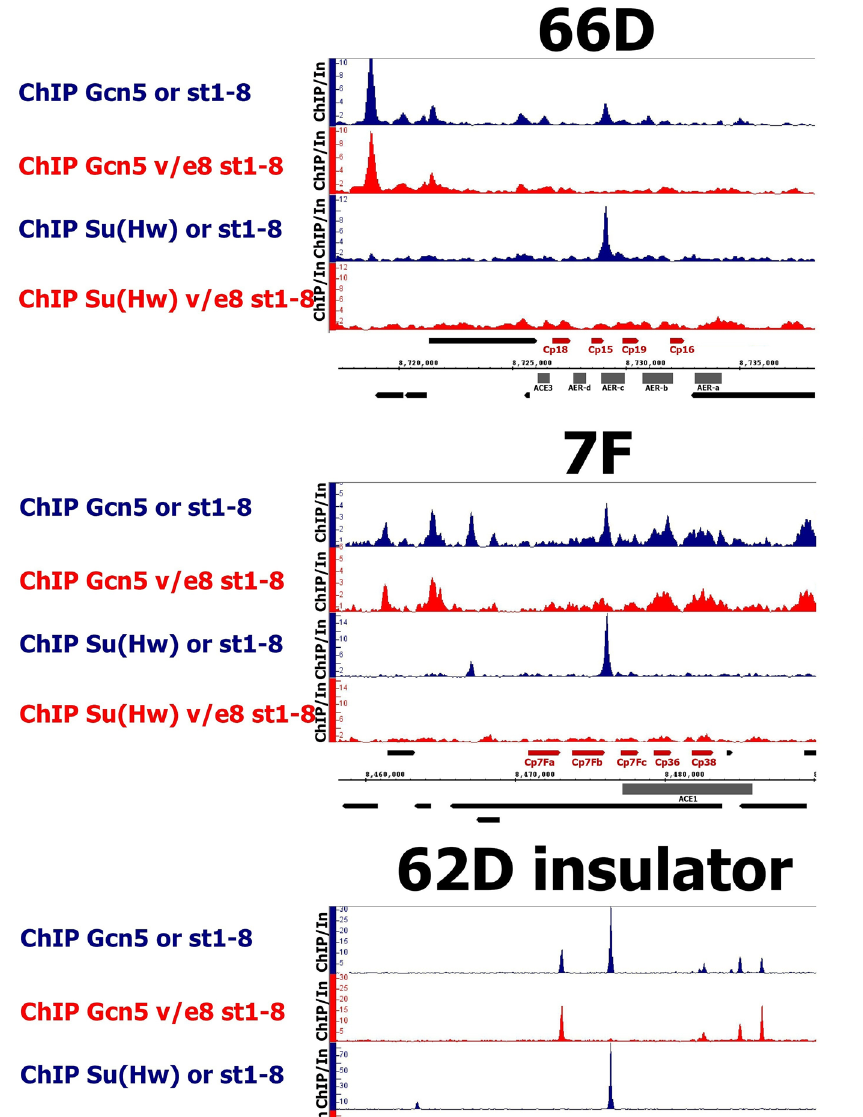
Figure 4. Gcn5 acetyltransferase is recruited to 66D and 7F loci in Su(Hw)-dependent manner. The binding profiles of Gcn5 acetyltransferase on 66D and 7F DAFCs and on 62D insulator in the wild-type (or, blue plots) and su(Hw) v / E8 (v/e8, red plots) ovaries. Only the ovaries containing egg chambers stages 1–8 were selected for analysis. Additionally, the distributions of Su(Hw) in the wild-type (or, blue plots) and su(Hw) v / E8 (v/e8, red plots) ovaries are shown. Protein binding levels were estimated by ChIP-Seq and represent the enrichment of ChIP-Seq signal over input. The coordinates of the X-axis correspond to the dm6 version of the Drosophila genome. The coordinates of the Y-axis represent the ChIP/Input ratio. The main chorionic genes and amplification regulatory regions of the loci are marked in red and in grey,